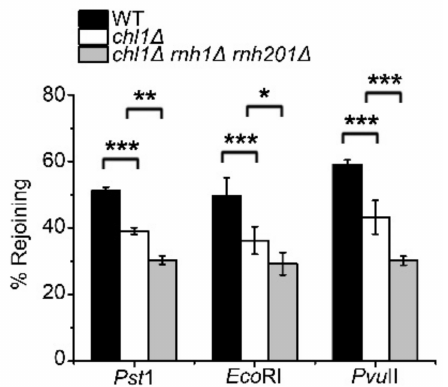
Figure 5. Chl1 is required for NHEJ. The LEU2 plasmids (pAL19) were linearized with Pvu II, Pst I, and EcoR I. The linearized plasmids were transformed into wild-type chl1 ∆ , and chl1 ∆ rnh1 ∆ rnh201 ∆ strains; the percentage of cells grown on leucine-deficient medium represented plasmid rejoining efficiency. Mean ± SEM of 3 replicates is shown. ***, p < 0.001; **, p < 0.01; *, p < 0.05, Student’s t